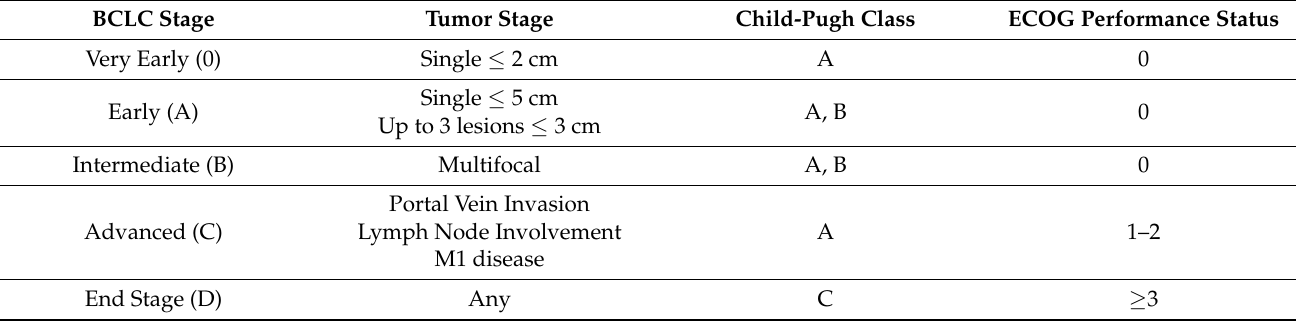
Table 3. Criteria for the Barcelona Clinic Liver Cancer (BCLC) staging